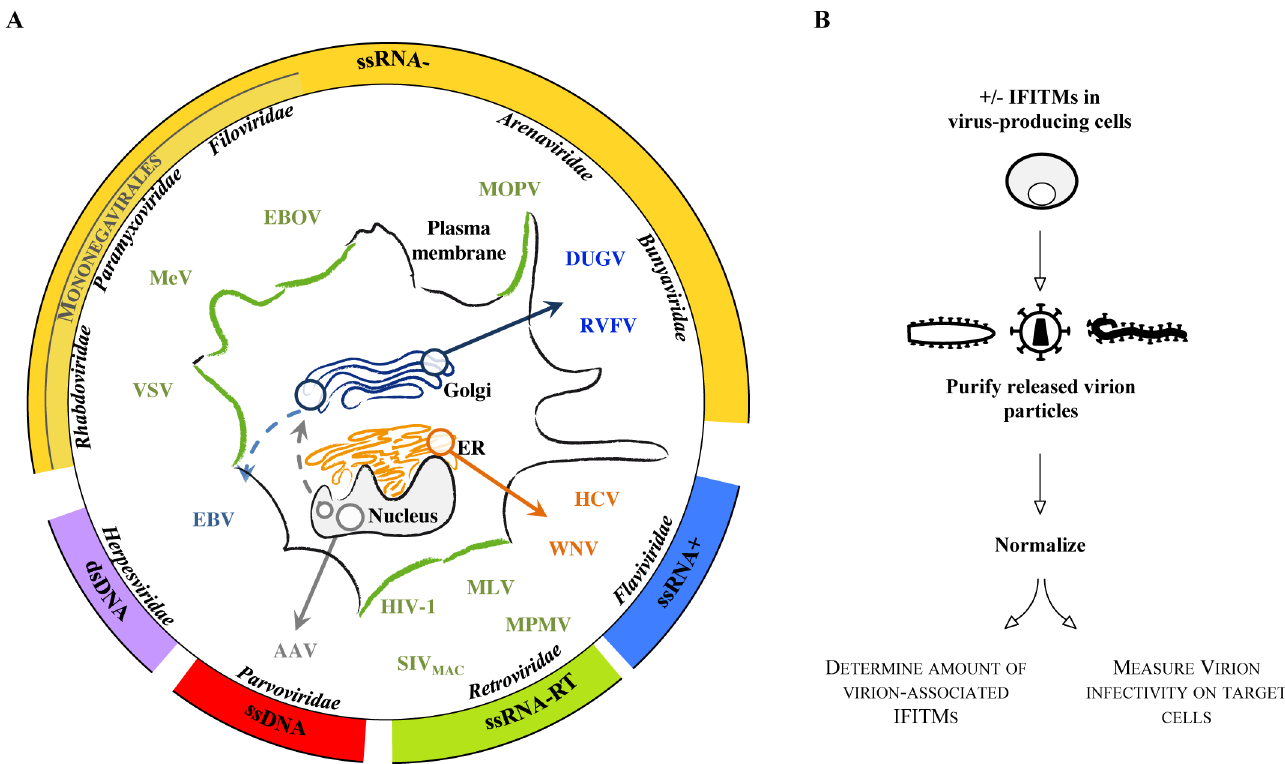
Fig 1. Experimental overview of the present study. Snapshot presentationof the viruses used in this study and schematic color-coded representation of the intracellular locationsof virion particle assembly(A). Experimental setup used to determine effects of IFITMs on the formation of infectiousviral particles (B). A comprehensive table of the viral systems used is providedin Supplementary S1